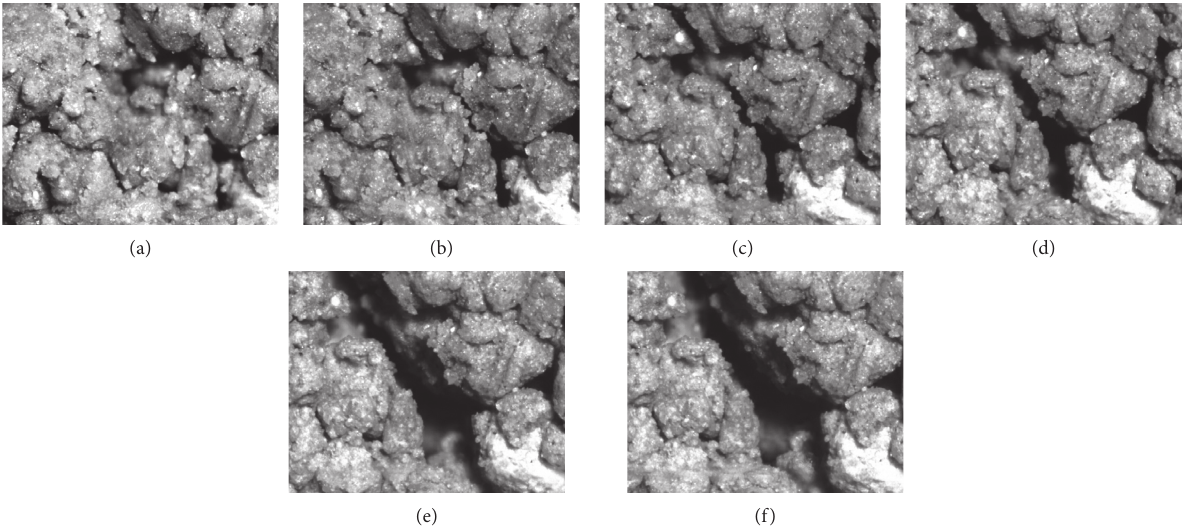
Figure 14: The continuous images under different tensile displacements in Zone 1: (a) L � 0.005 mm; (b) L � 0.045 mm; (c) L � 0.065 mm;